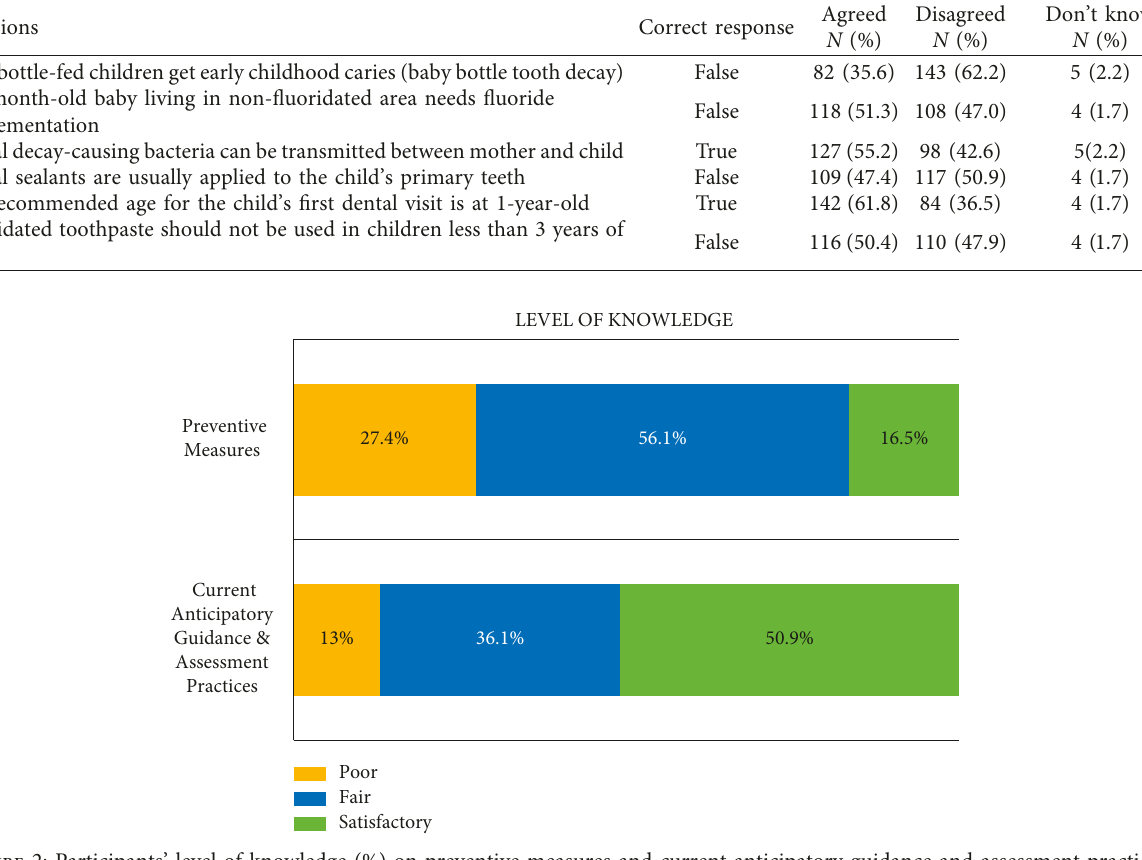
Table 2: Responses to knowledge questions on preventive measures.